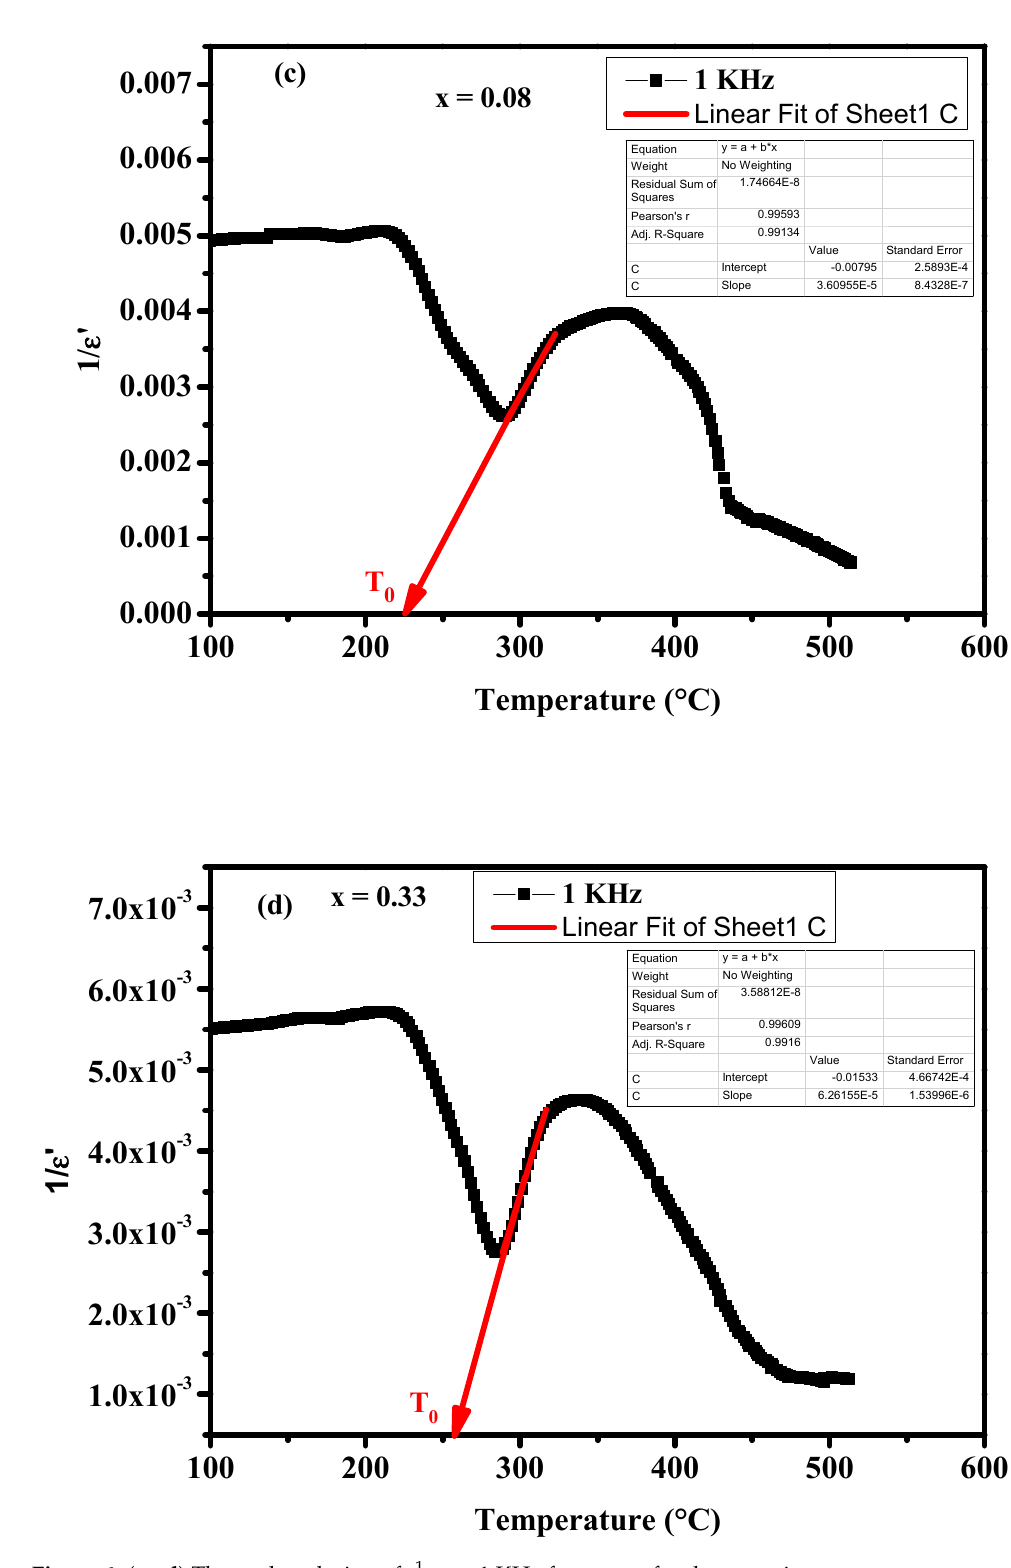
Figure 6. ( a − d ) Thermal evolution of ε at a 1 KHz frequency for the ceramics. ' r